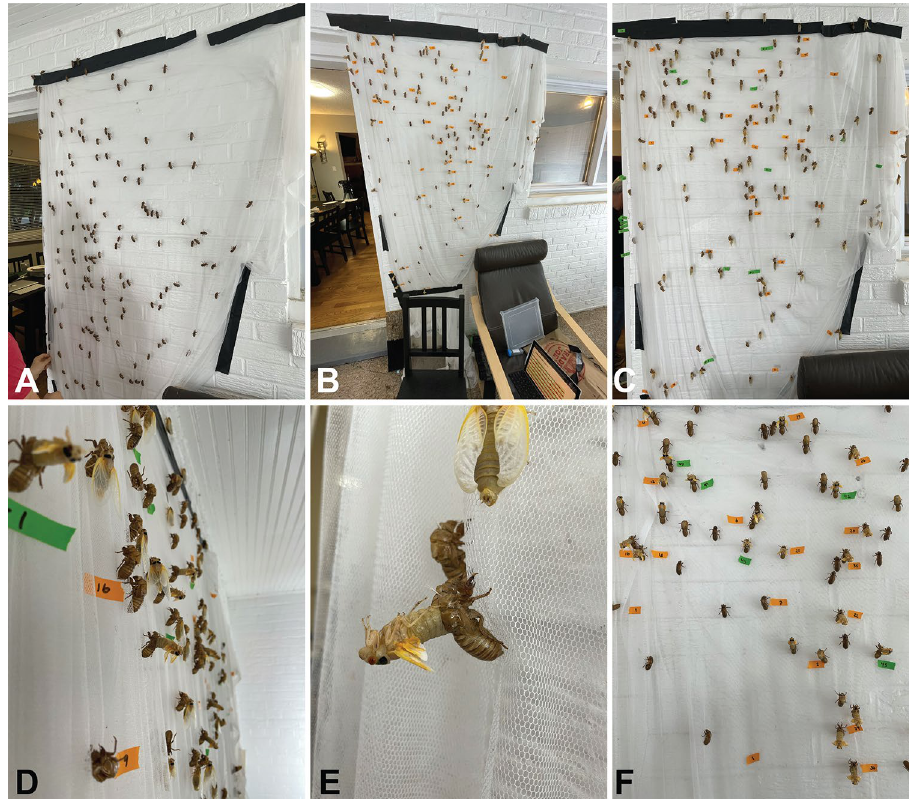
Figure 2. Eclosion and wing expansion on a “cicada wall”. An 8-foot wall of insect netting was mounted in a walled-in porch. Nymphs were placed on the wall and allowed to crawl freely until they settled to initiate emergence. ( A ) Nymphs have climbed up the mesh wall. ( B ) Cicadas emerging on the wall with tape labels indicating timing intervals. ( C ) As more cicadas emerge, more colors of tape are used to differentiate expansion at different times. ( D ) Side-view of the emergence wall. ( E ) A cicada in the backwards-bend phase of eclosion. When it flips forward to extract the abdomen, this is time "zero". ( F ) Due to the quick pace of emergence, many cicadas were not labelled. Cicadas then eclosed and were returned to their site of